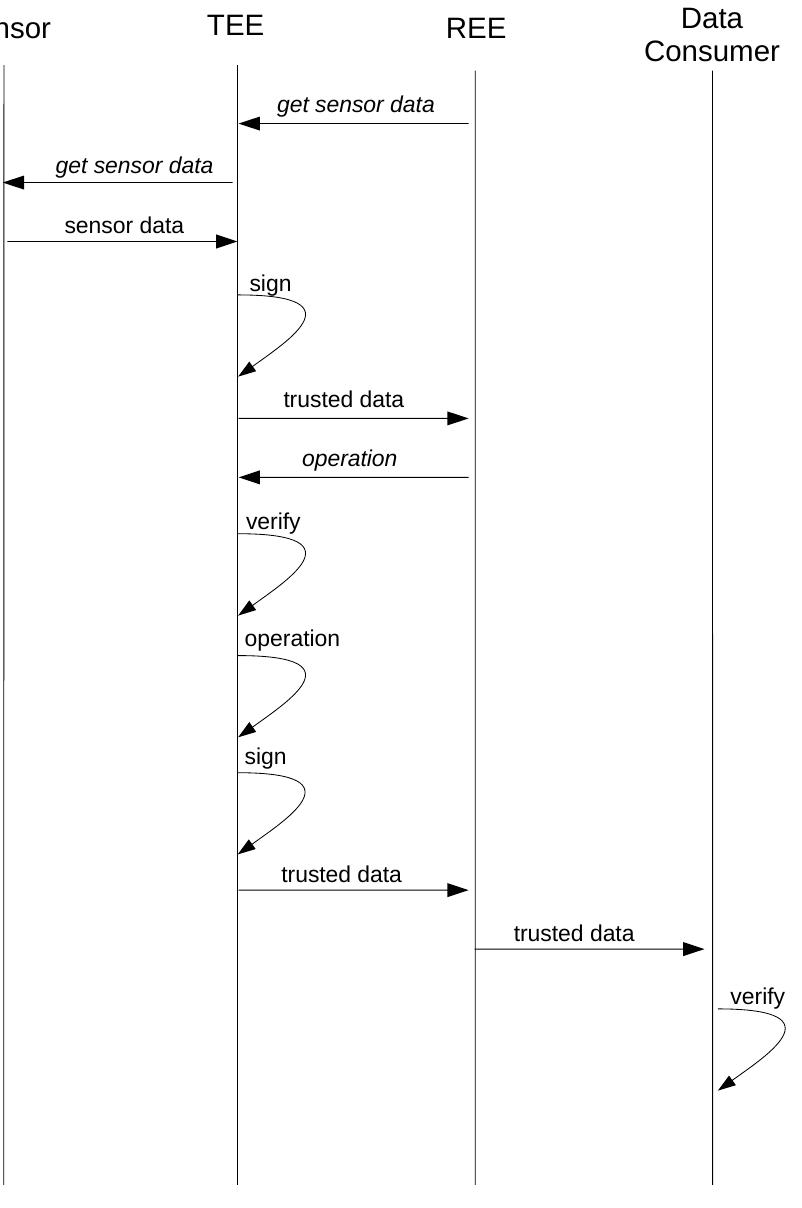
Figure 4. On-board sensor data life